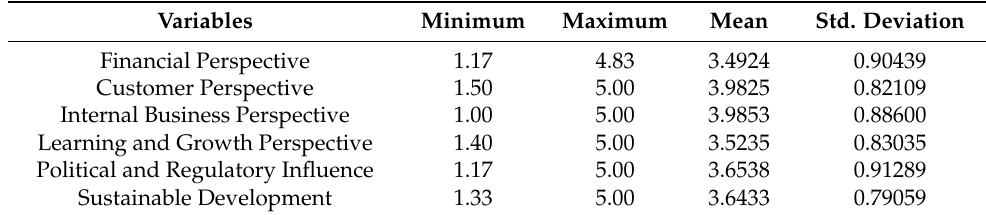
Table 2. Descriptive analysis of